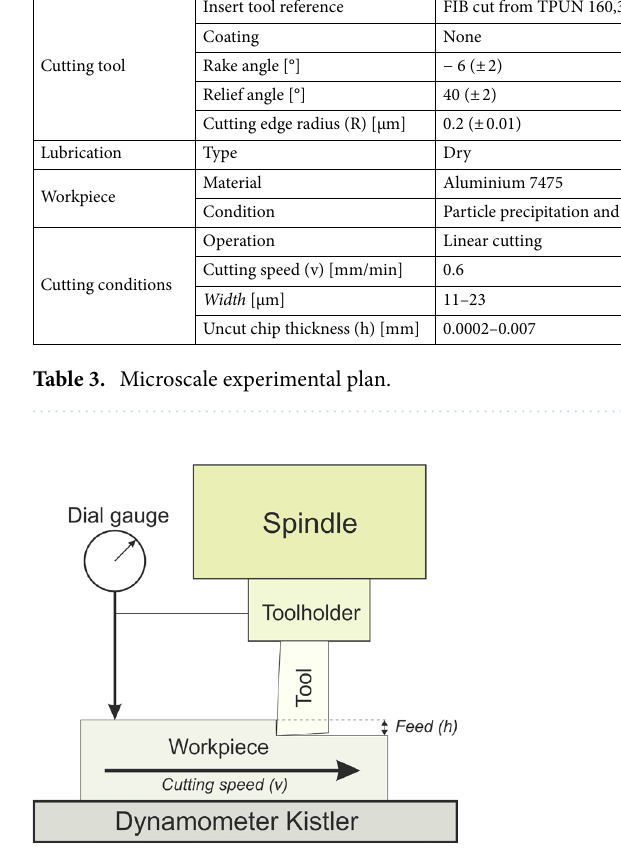
Figure 9. Sketch of the macroscale cutting test setup.